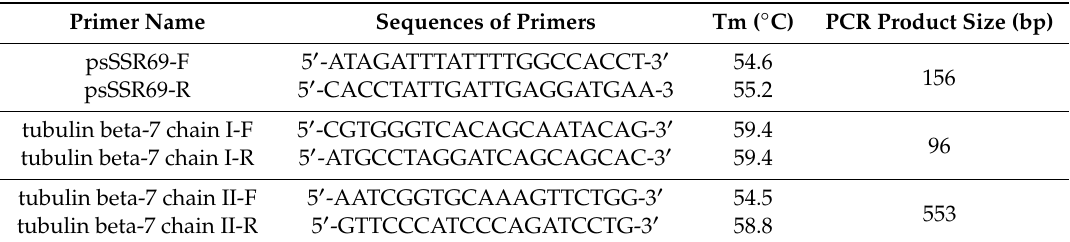
Table 1. Primer pairs used for amplification of opium poppy DNA. Tm: Melting